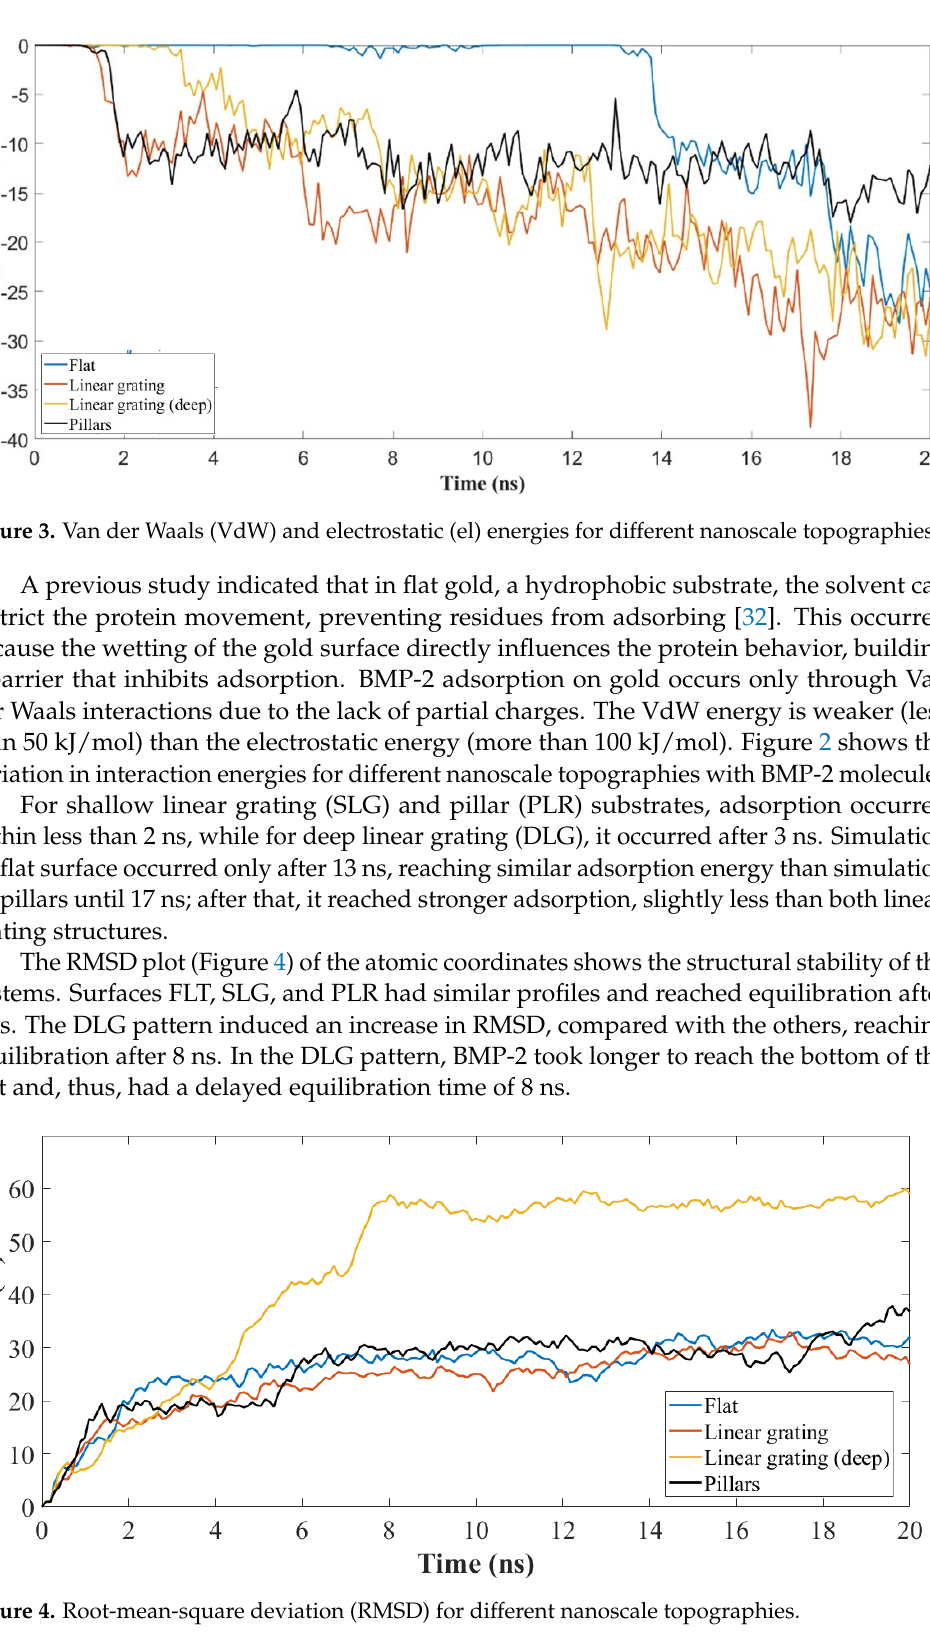
Figure 4. Root-mean-square deviation (RMSD) for different nanoscale topographies.